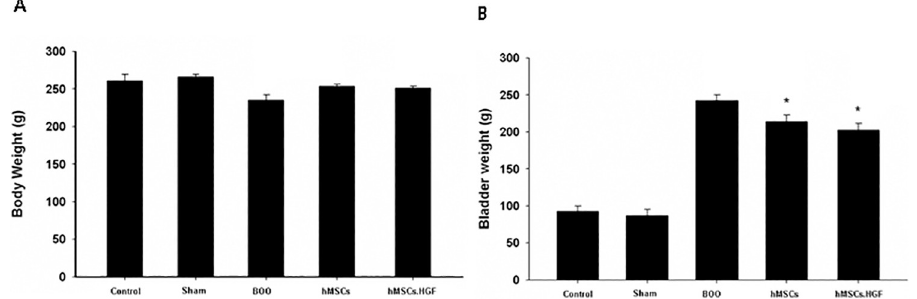
Fig 1. Change in body and bladder weight after transplantation. A. There was no significant difference in body weight between groups. B. The bladder weight was increased in the group with BOO than in the sham operation group. The group transplanted with hMSCs and HGF-overexpressing hMSCs showed decreased bladder weight than the group with BOO. Sham = sham operation, BOO = bladder outlet obstruction, hMSCs = human mesenchymal stem cells, hMSCs.HGF = HGF overexpressing human mesenchymal stem cells. � p <